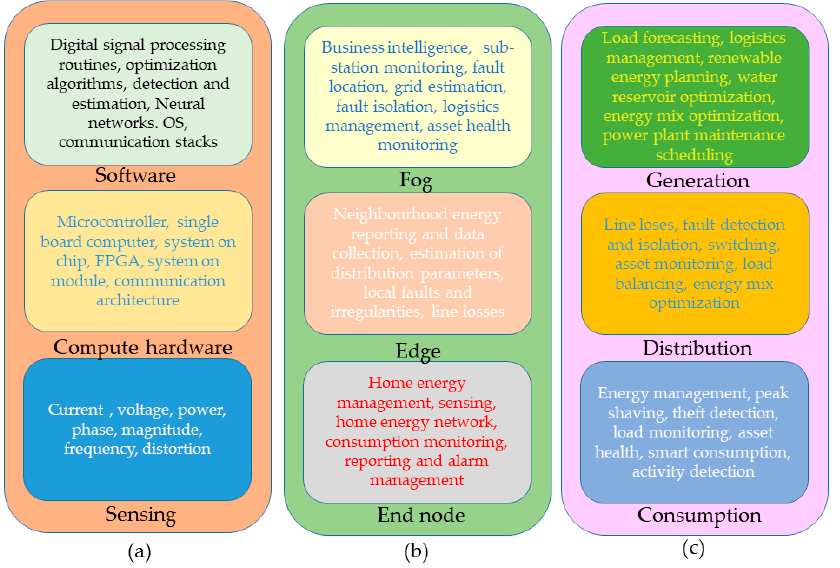
Figure 2. Functionality and nature of smart meter: ( a ) smart meter as combination of sensing, hardware, and software components; ( b ) functionality of smart meter according to the location in IoT stack; ( c ) functionality of smart meter according to the location in the